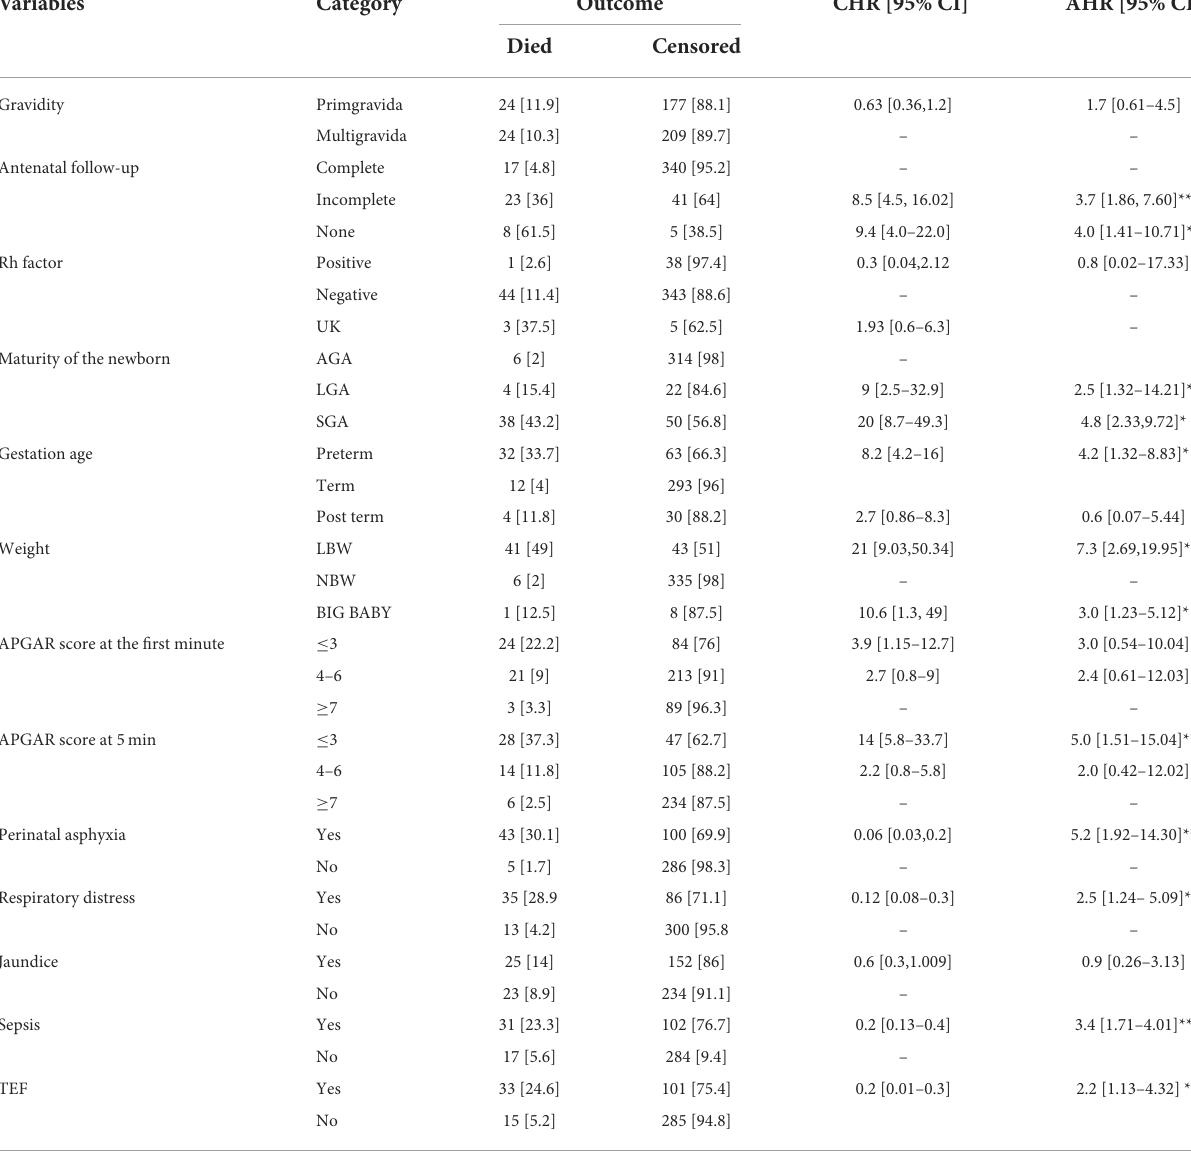
TABLE 6 Results of the bivariable and multivariable Cox regression on predictors of neonatal mortality in TASH, Addis Ababa, Ethiopia, 1 January 2015 – 30 December 2021.